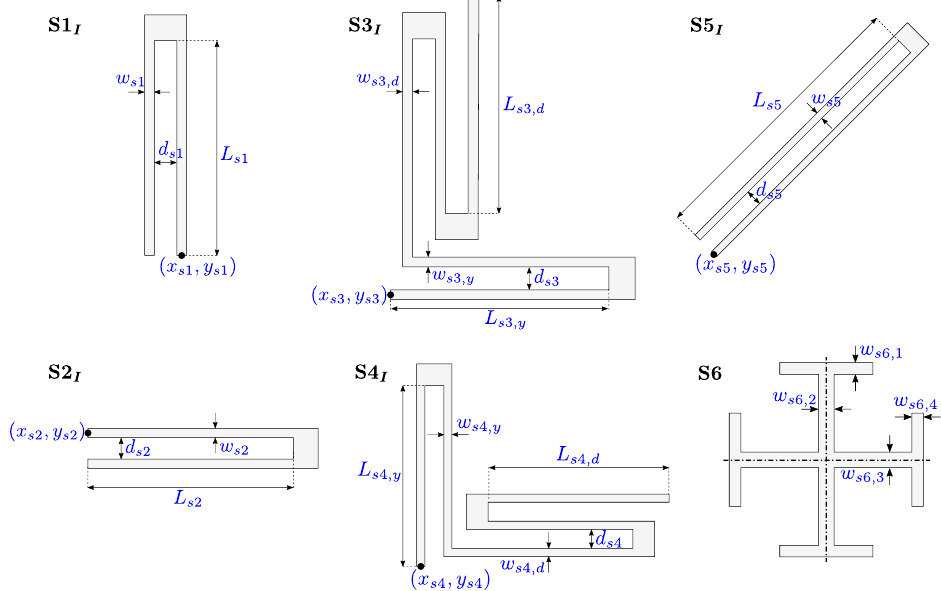
Figure 3. Design variables related to the geometry of the springs (redrawn from